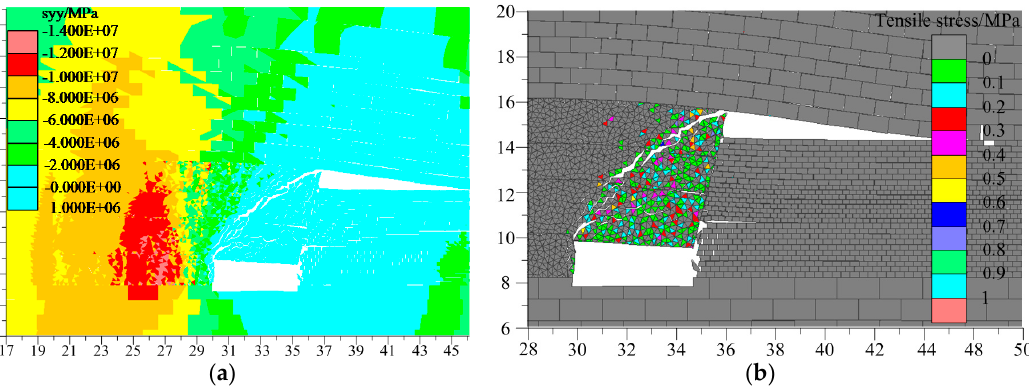
Figure 9. Simulated stress distribution map in the entry-surrounding rock: (a) Vertical stress; (b) tensile stress.